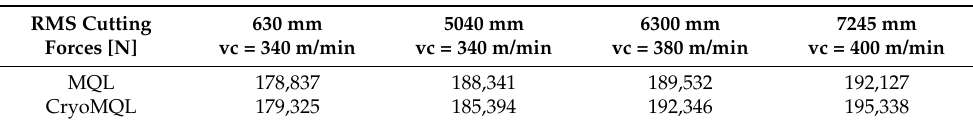
Table 3. Cutting forces.